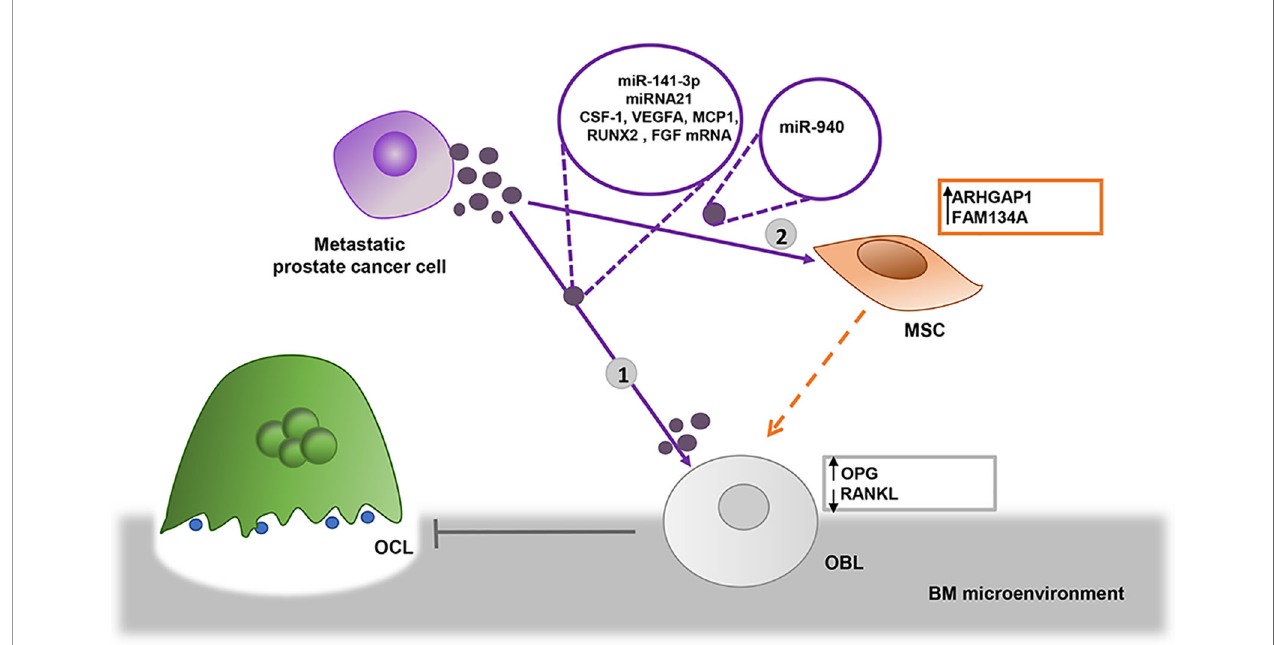
FIGURE 2 | EVs derived from prostate metastatic cells induce osteoblastic lesions. 1) Bone metastatic prostate cancer cells transfer miR-141-3p into osteoblasts (OBL) via EVs, where it downregulates the expression of osteoprotegerin (OPG), altering the balance between OBL/OCL ratio, promoting OBL activity as a result (76). EVs from prostate cells enhance OBL viability by delivering miRNA 21 and CSF-1, VEGFA, MCP1, RUNX2, and FGF2 transcripts (47) 2) Prostate cancer cells may indirectly favor osteoblastic bone lesions transferring miR-940 via EVs, which target Rho GTPase Activating Protein 1 (ARHGAP1) and Reticulophagy regulator 2, Family with sequence similarity 134, member A (FAM134A) in mesenchymal stromal cells (MSCs) induce their differentiation in OBLs